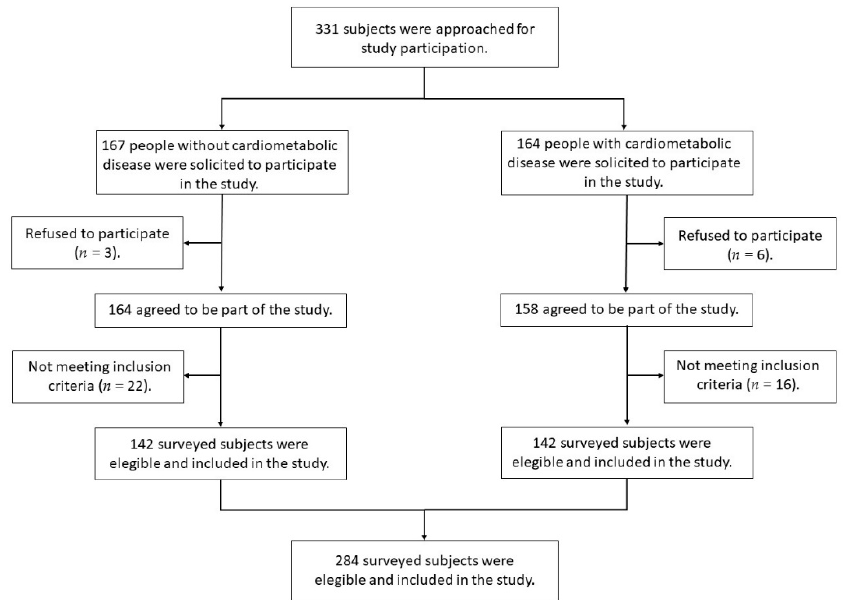
Figure 1. Flow diagram of study design.